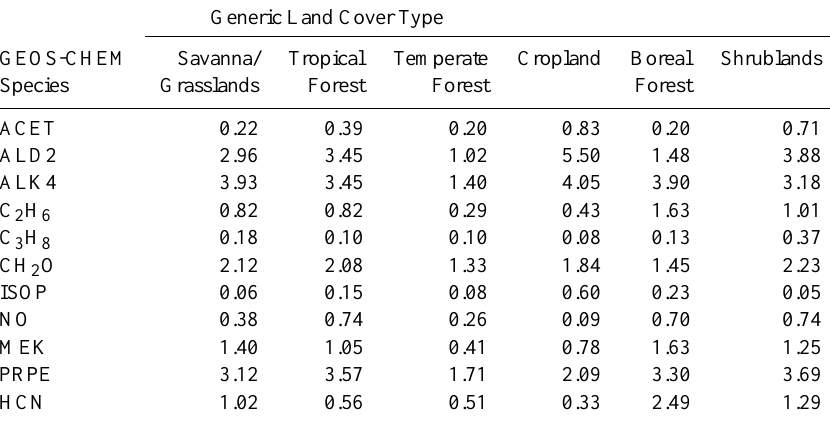
Table 5. Factors to convert NMOC Emissions (kgday − 1 ) to GEOS-Chem chemical species (moles-speciesday − 1 ) for each generic land cover class in which a fire